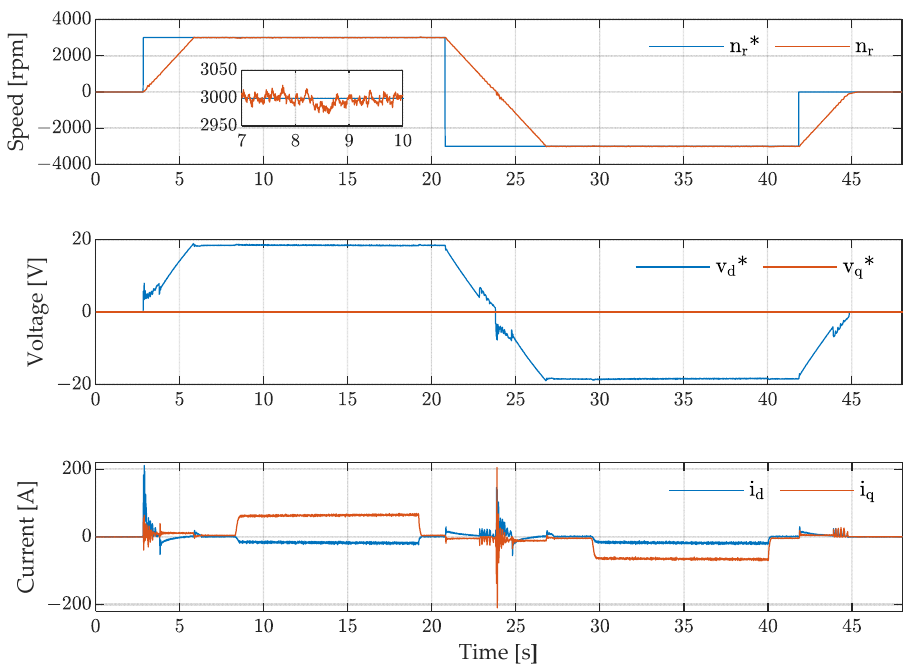
Figure 24. Ramp ‐ up and ramp ‐ down with the nominal reference speed and 100% load applied at Figure 24. Ramp-up and ramp-down with the nominal reference speed and 100% load applied at steady ‐ state, with a required power factor of 0.95: speed, dq voltages, dq currents. steady-state, with a required power factor of 0.95: speed, dq voltages, dq currents.